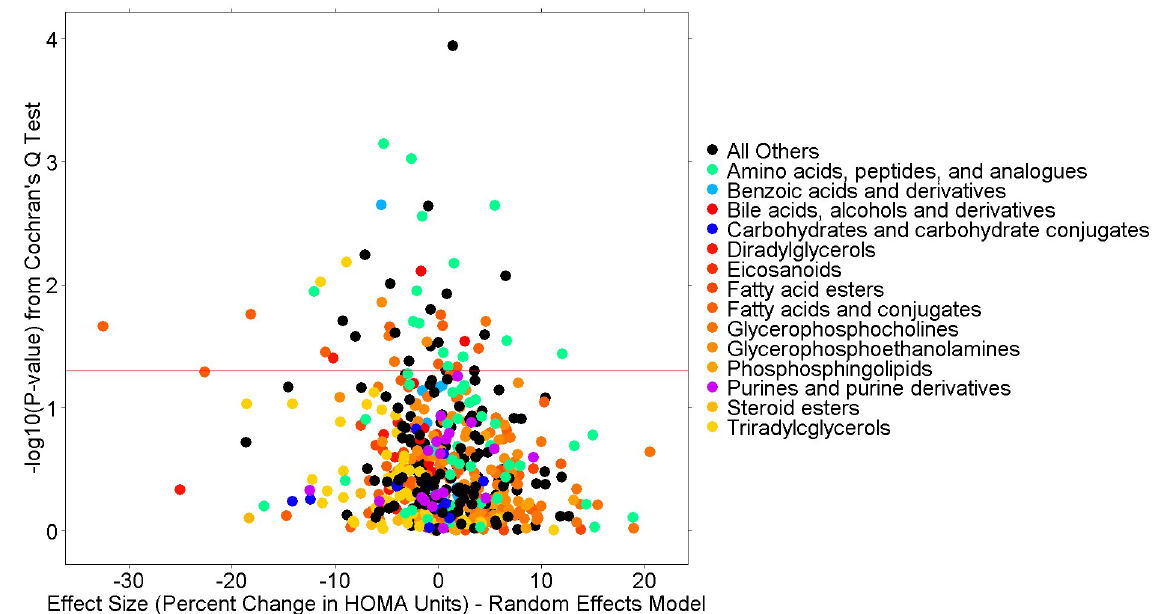
Fig 4. Heterogeneity volcano plot from full model meta-analysis.